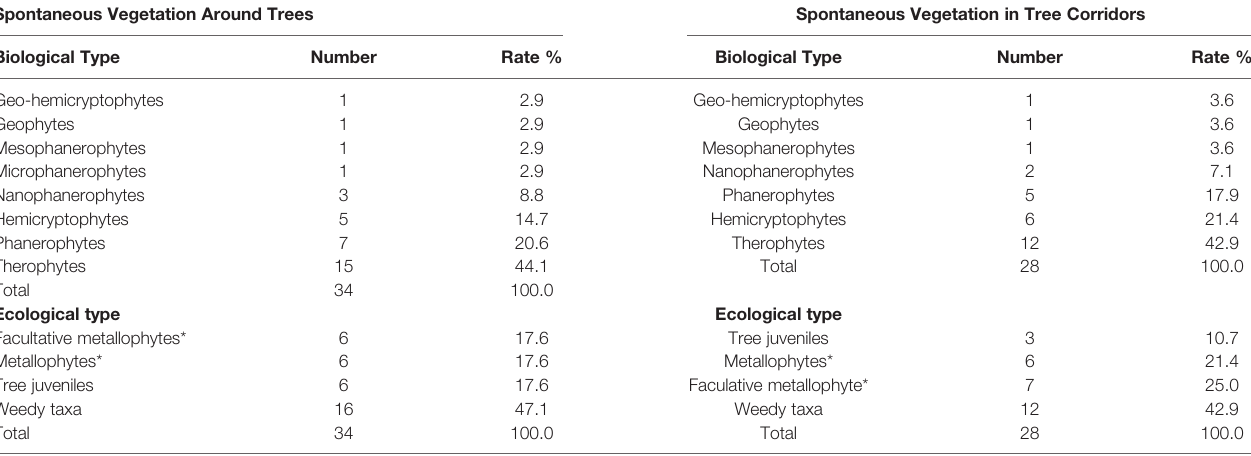
*(36, 37). TABLE 5 | Proportion of ecological and biological types of spontaneous vegetation at Kipushi TD. Spontaneous Vegetation Around Trees Spontaneous Vegetation in Tree Corridors Biological Type